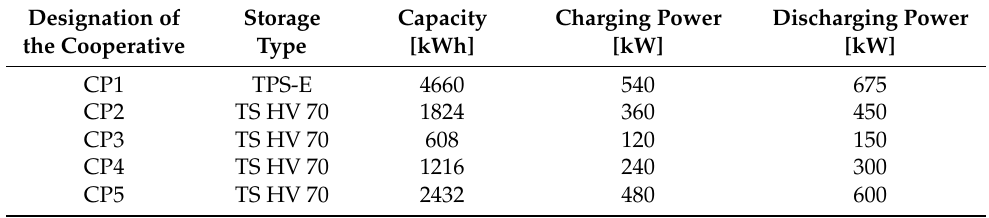
Table 2. Energy storage